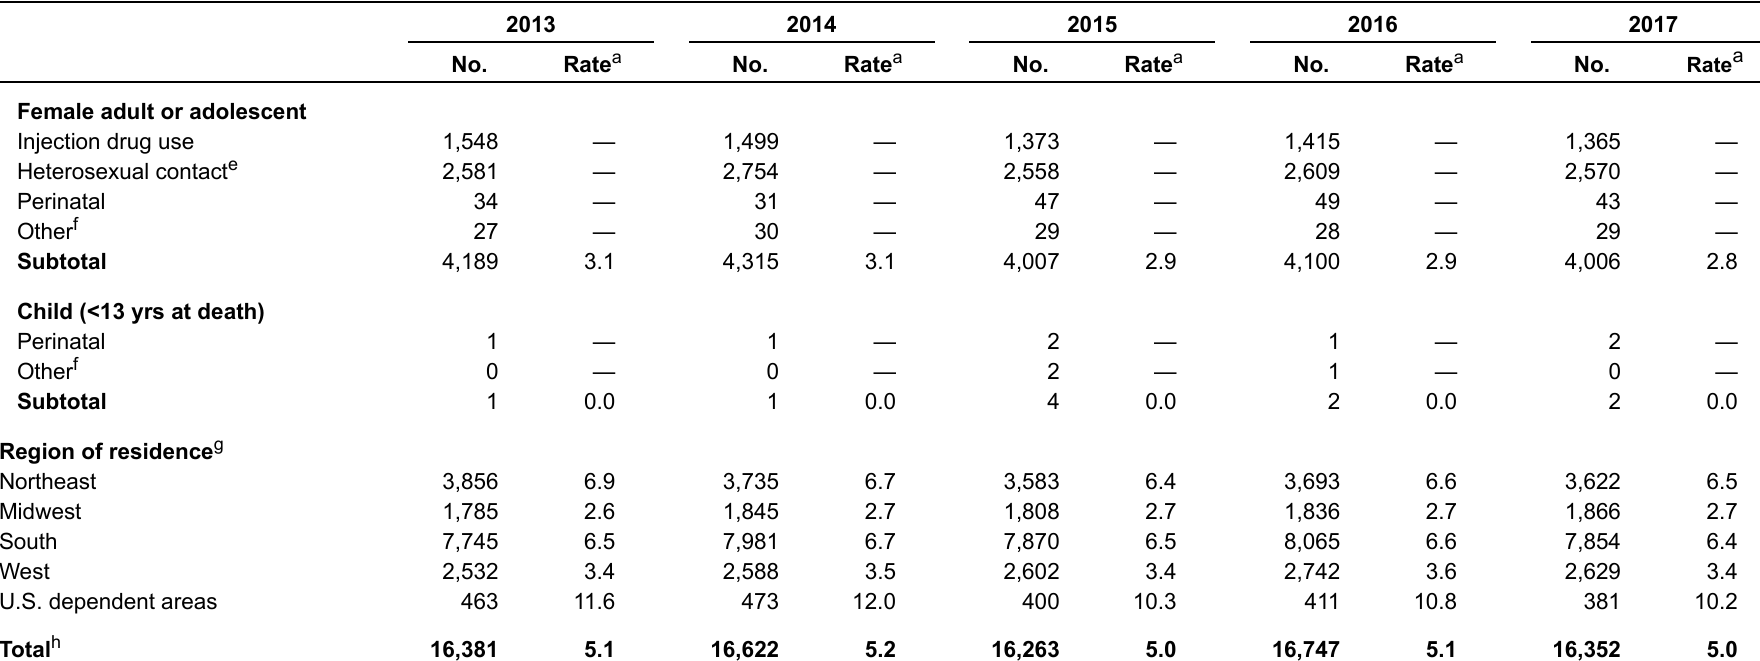
Table 18b. Deaths of persons with diagnosed HIV infection, by year of death and selected characteristics, 2013–2017—United States